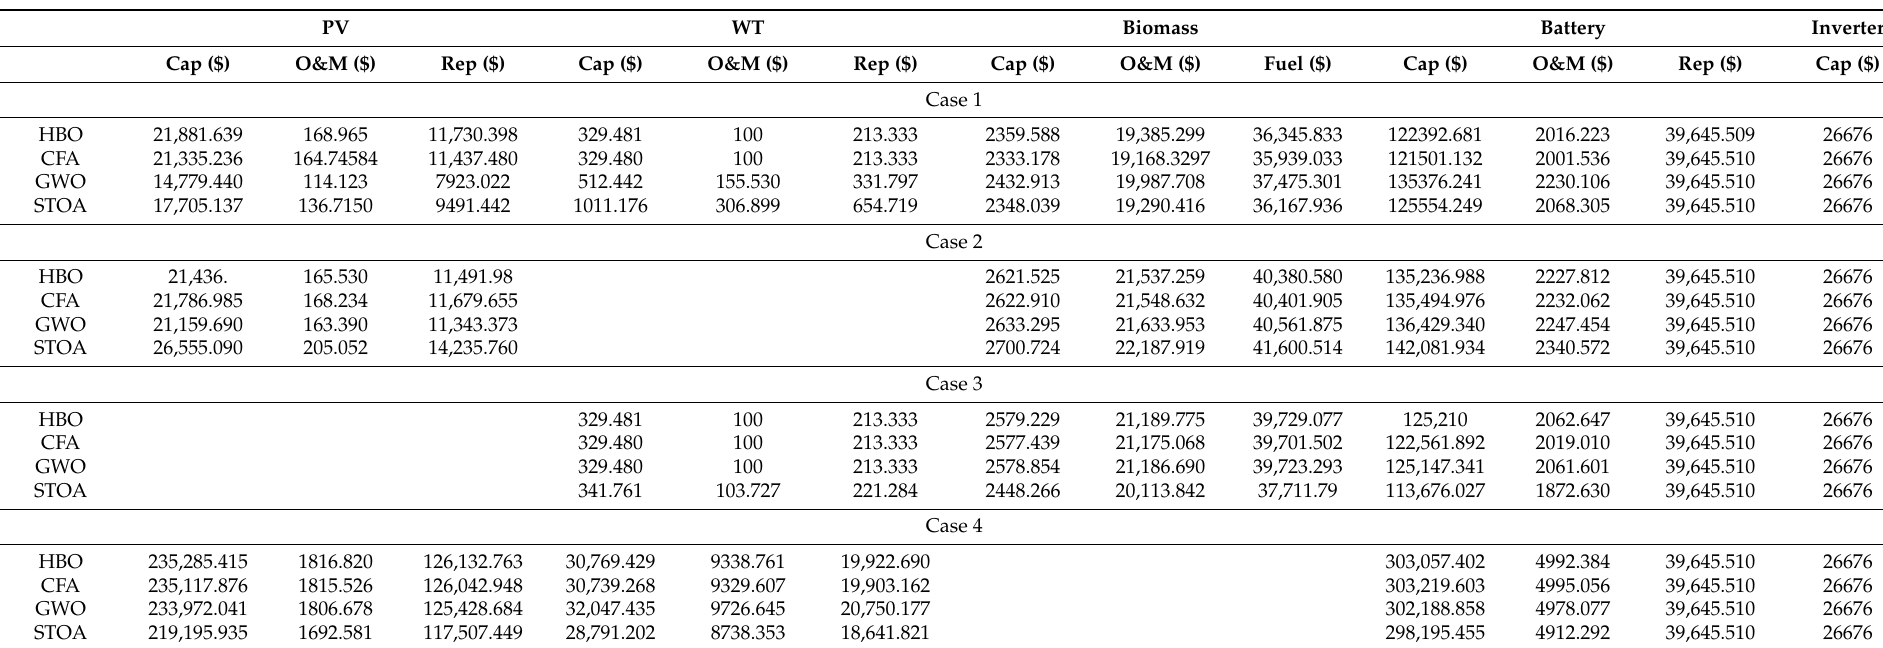
Table 11. The contribution of the yearly cost of the system regarding the type of cost which includes the yearly interest of capital cost, operating and maintenance costs, and annual replacement